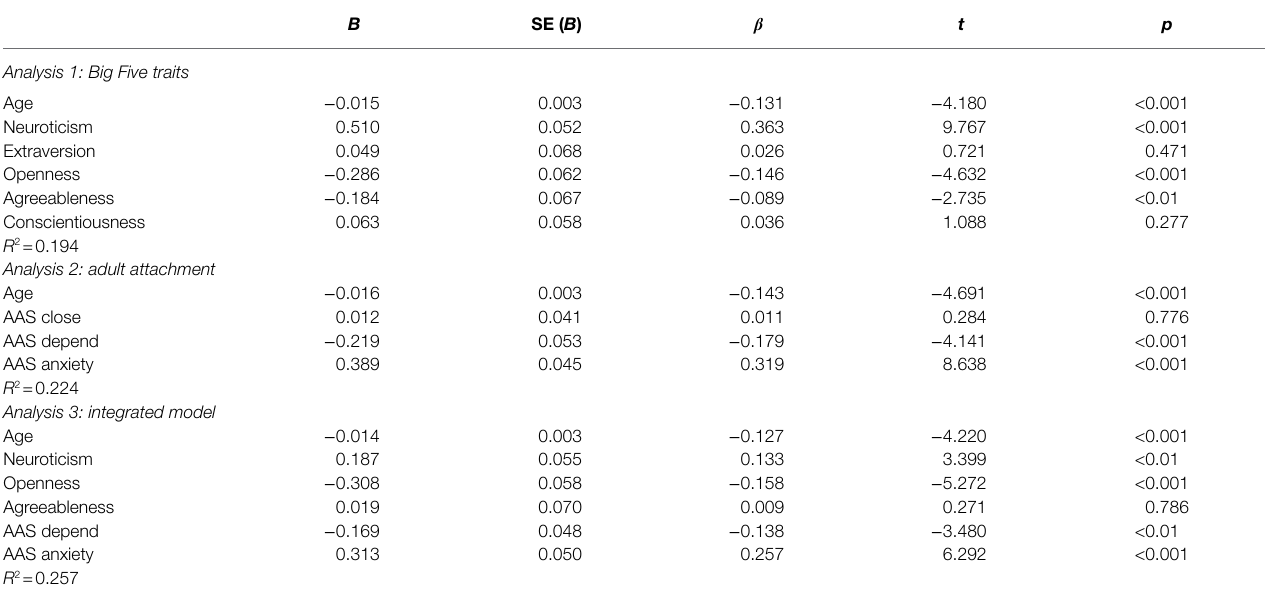
TABLE 4 | Linear regression models predicting romantic jealousy in 847